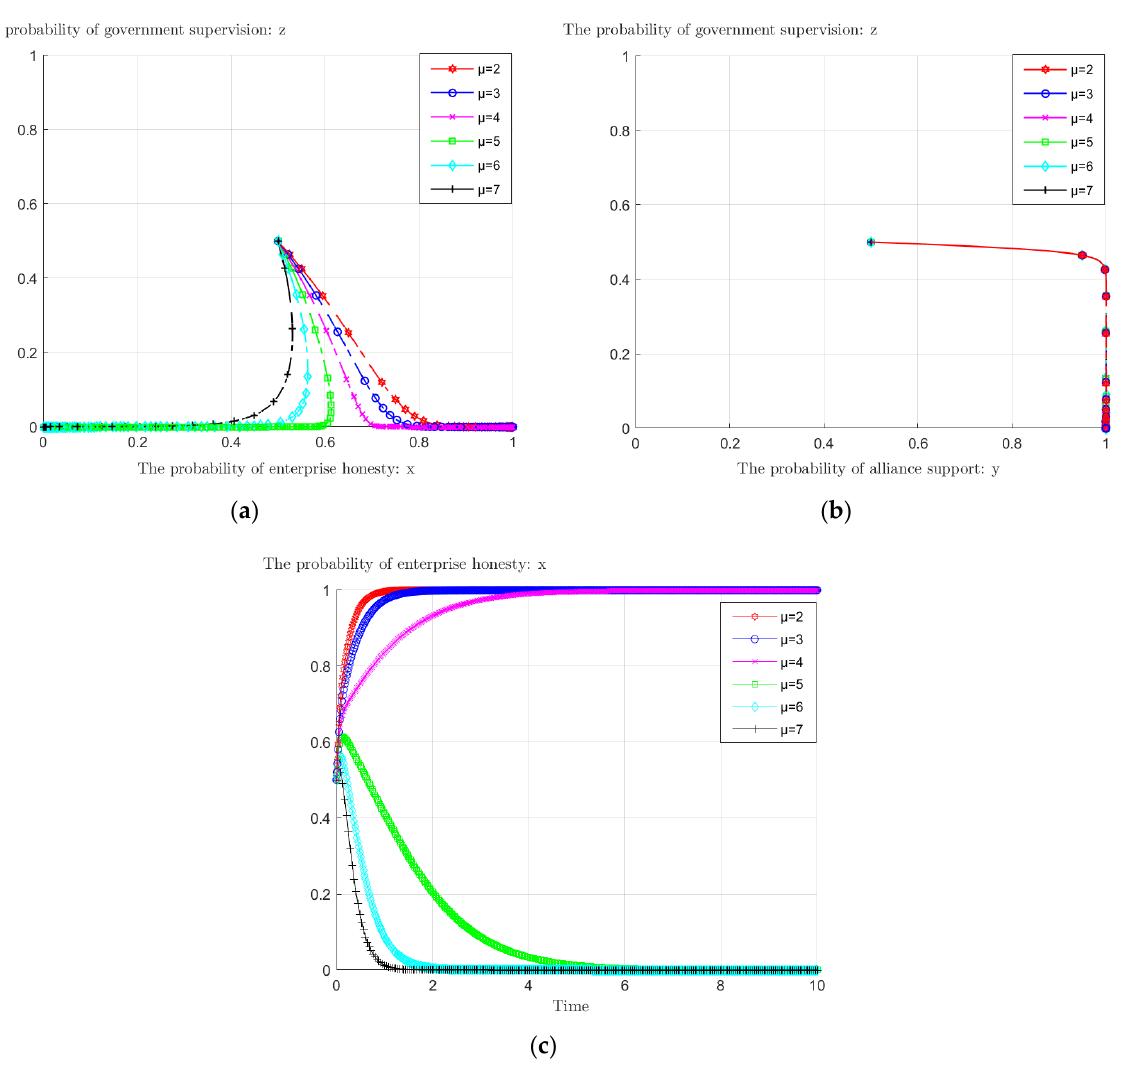
Figure 6. The impact of carbon tax rate μ on: ( a ) enterprises’ and governmental behavioral evolution; ( b ) alliance’s and governmental behavioral evolution; ( c ) enterprises’ behavioral evolution.